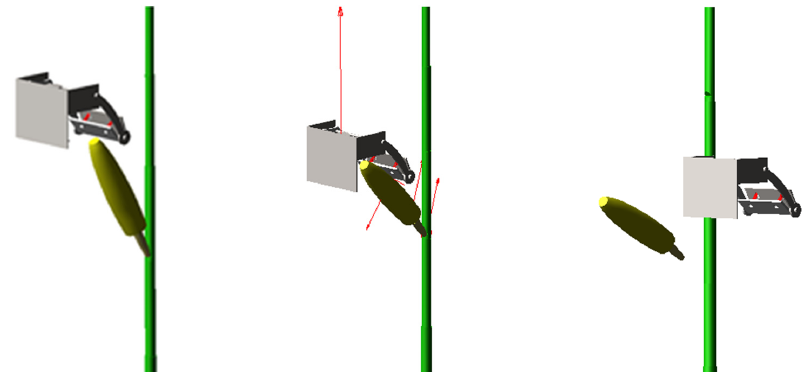
Figure 2. Simulation process of picking ears.